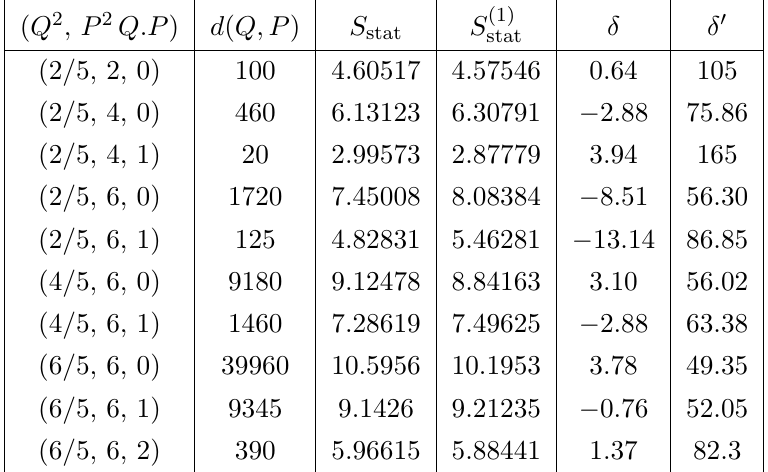
Table 7 . Comparison of the statistical entropy and statistical entropy at one loop for 5A